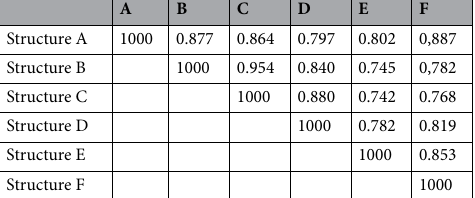
Table 4. PN-GDDA results for comparison of structures